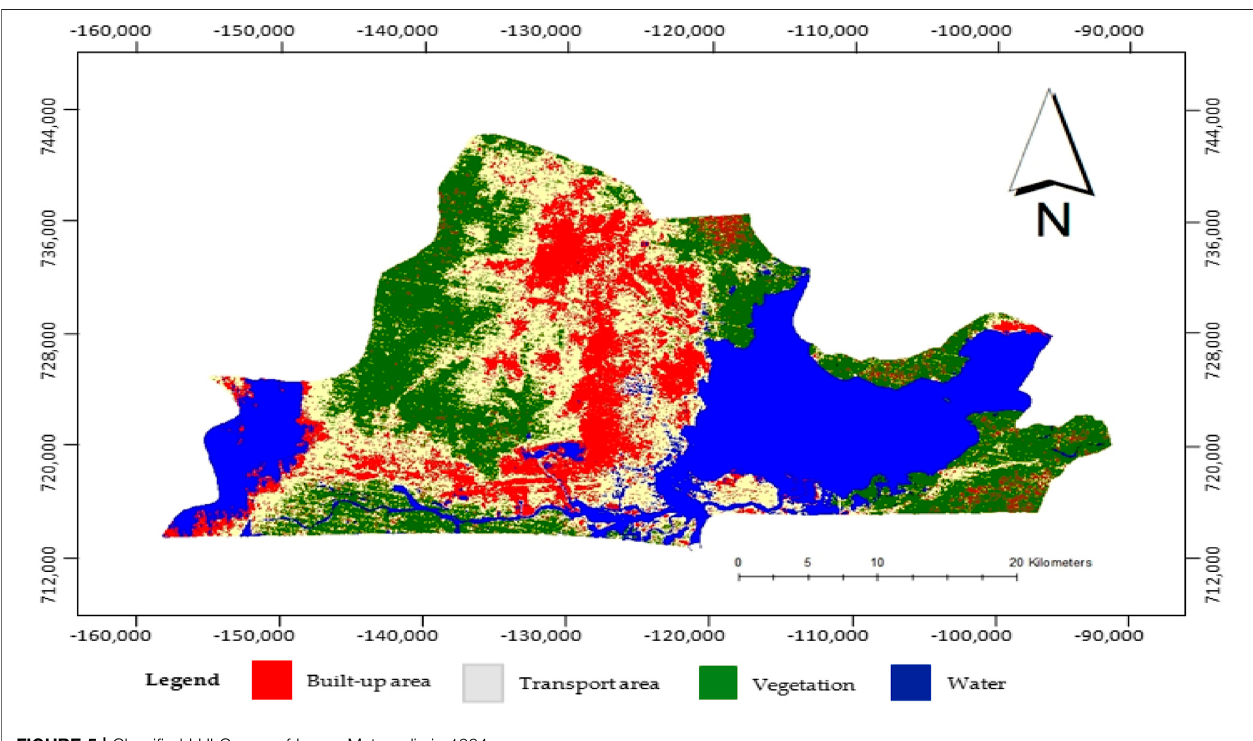
FIGURE 5 | Classi fi ed LULC map of Lagos Metropolis in 1984.